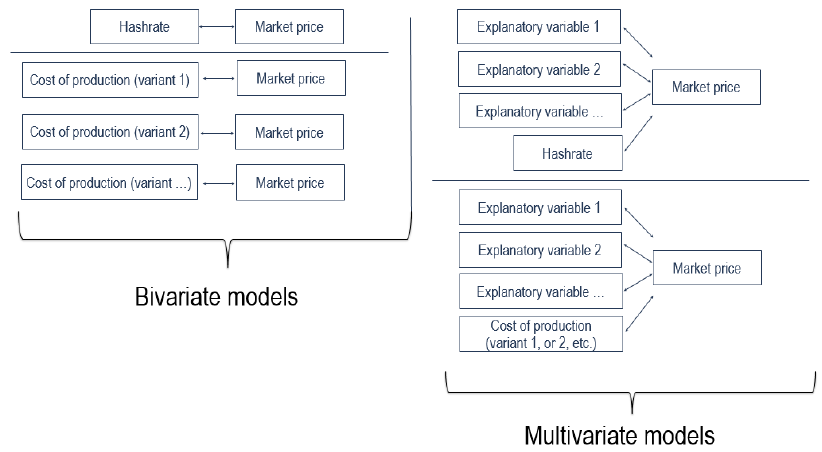
Figure 1. Modeling strategy to investigate the nature of the relationship between the bitcoin market price and the hashrate (either directly or through the proxy of production